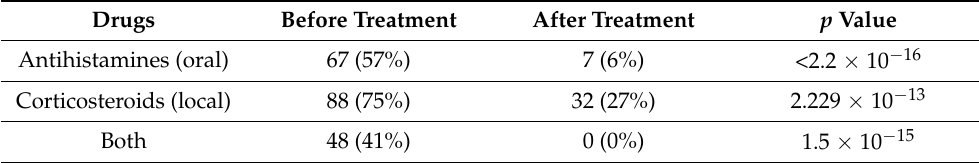
Table 5. Pharmacological treatment of AR in the placebo group. Drugs Before Treatment After Treatment p Value Antihistamines (oral) 66 (78%) 0.16